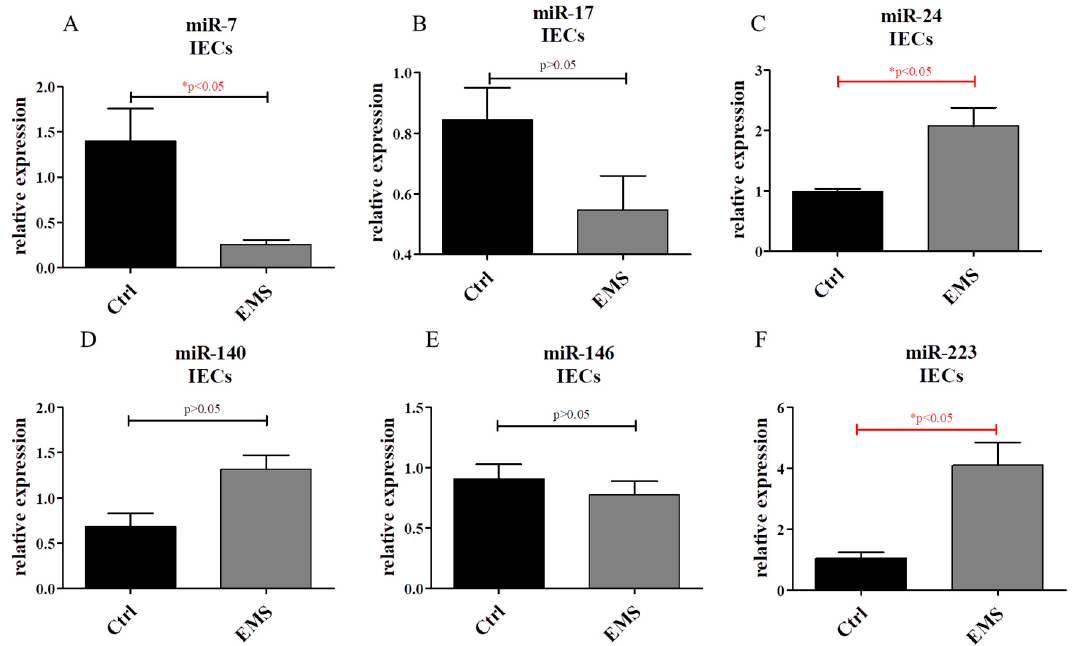
Figure 10. miR expression in IECs. Using PCR, the expression of the following miRNAs was investigated: miR-7 ( A ); miR-17 ( B ); miR-24 ( C ); miR-140 ( D ); miR-146 ( E ); and miR-223 ( F ). Results expressed as mean ± S.D. * p < 0.05.